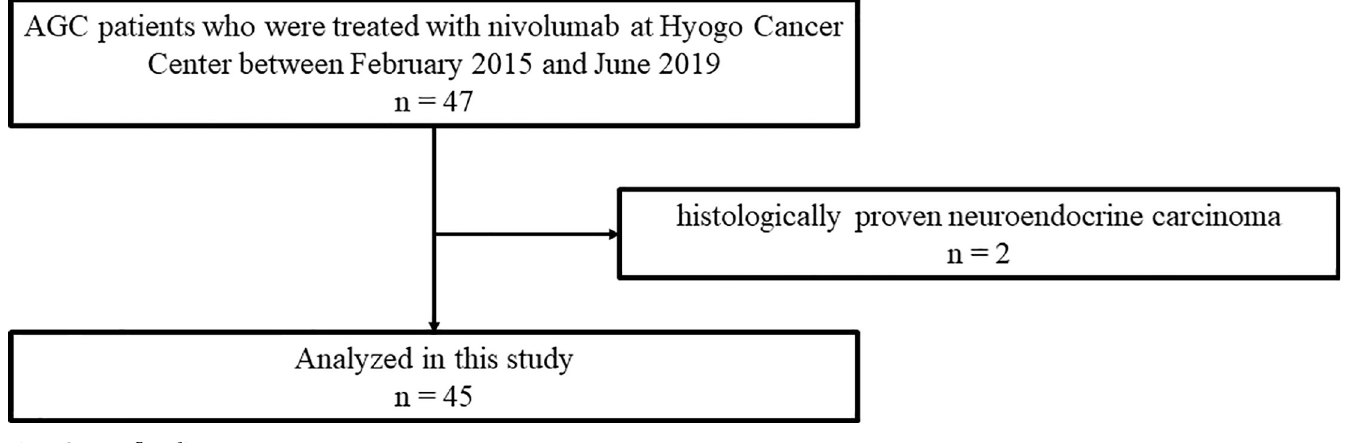
Fig 1. Consort flow